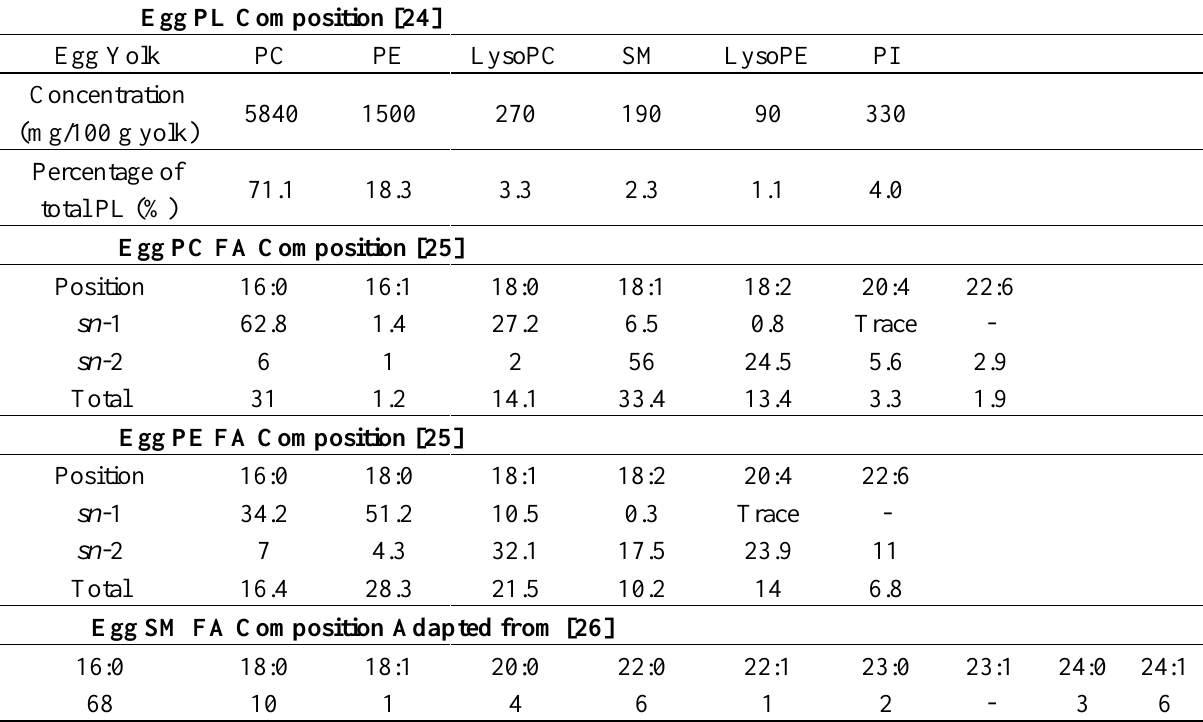
Table 1. Typical Composition of Egg